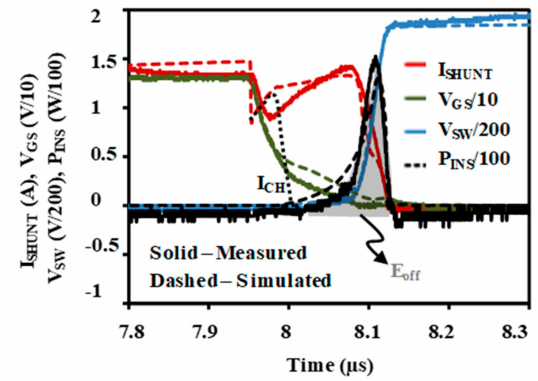
Figure 7. Simulated and measured waveforms for DUT LOW during the turn-o ff . I SHUNT , V GS , and V SW are referenced in Figure 6. P INS is the instantaneous power (product of V SW and I SHUNT ) and I CH is the simulated current through the channel of the SJ-MOSFET.